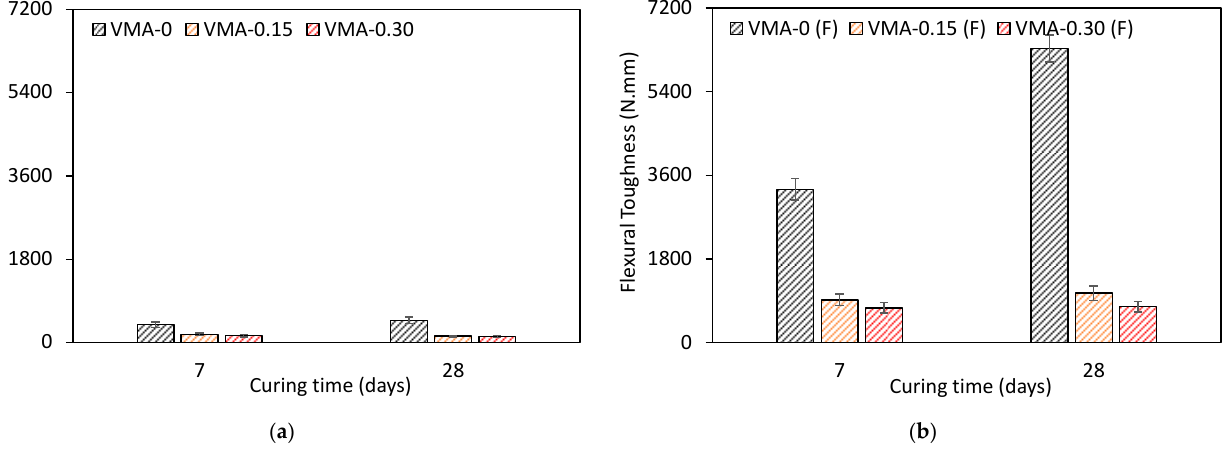
Figure 14. Flexural toughness of the extruded specimens for fiber-free ( a ) and fiber-reinforced ( b ) mixtures.